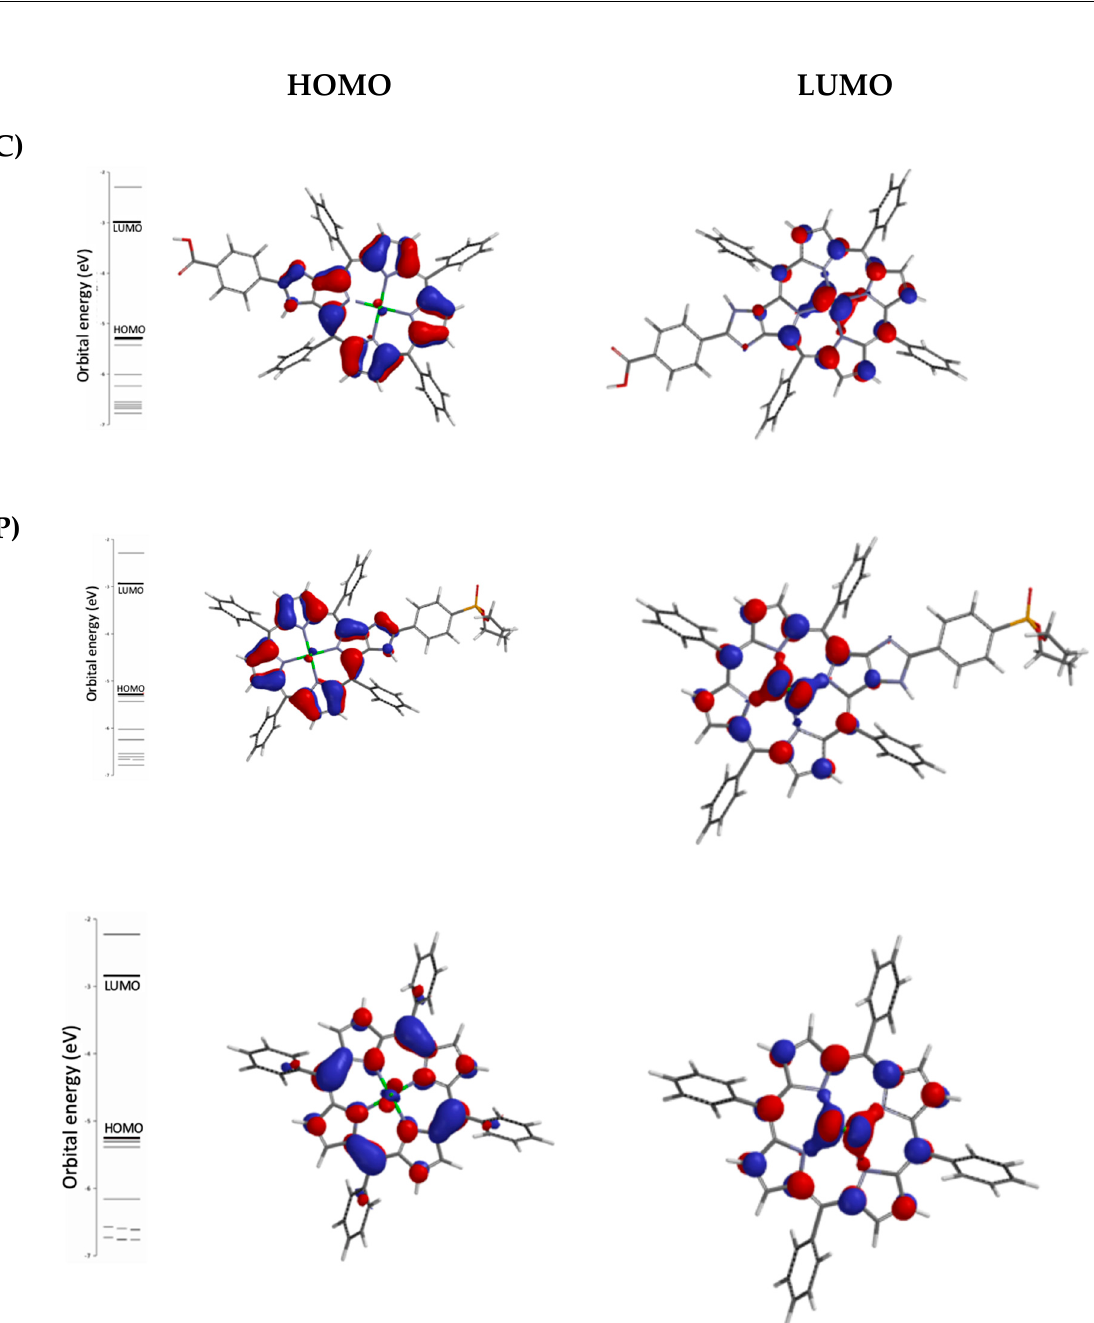
Figure 2. The isodensity plot of HOMO and LUMO orbitals for porphyrins Mn(TPP) , Mn(TMPIC) and Mn(TMPIP) obtained from DFT calculations.